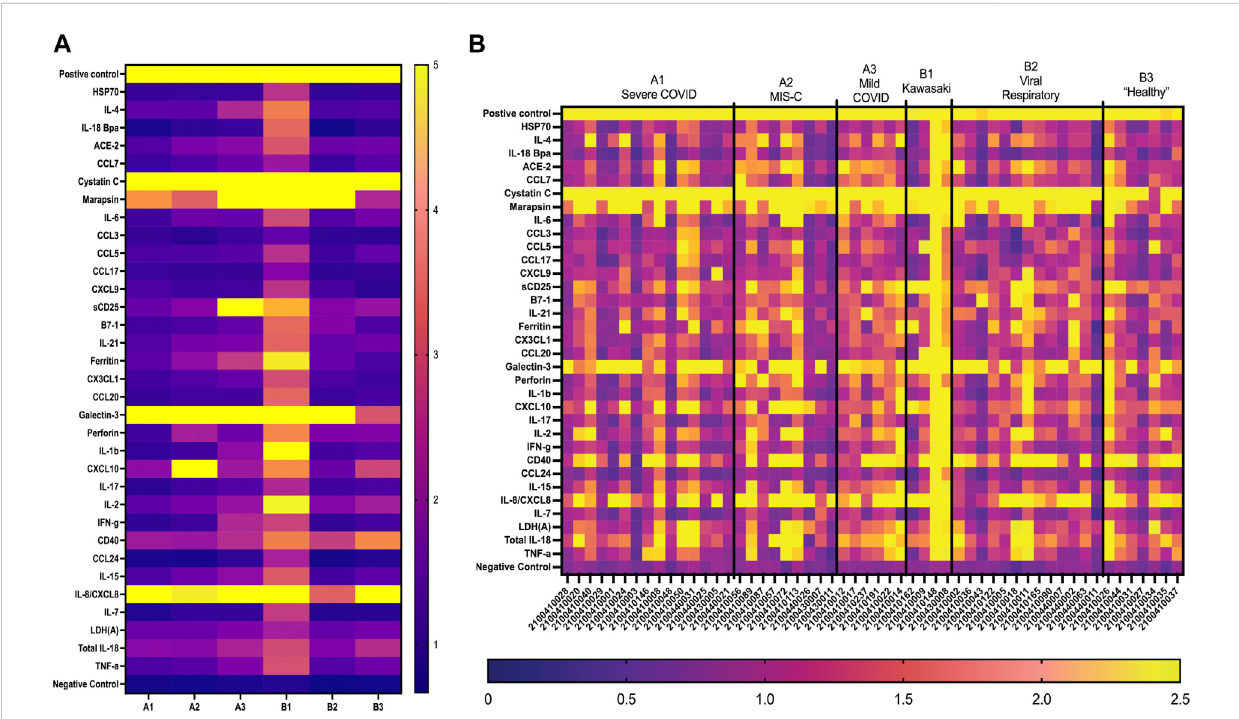
FIGURE 4 GCFPdetection ratioforpatientsalivasamples.Salivasamplesobtainedfromeachofthepatientcohorts;54samples(A1=15,A2=9,A3=6,B1=4, B2 = 13, B3 = 7) were run over the fi rst-generation biosensor chip. (A) Heat maps generated for each cohort using the mean detection ratio for each analyte, showing candidate biomarkers for the A2 (CXCL10), A3 (sDC25) and B1(IL-1 β and IL-2) cohorts. (B) Heat maps generated for each individual patient demonstrate individual variation in disease